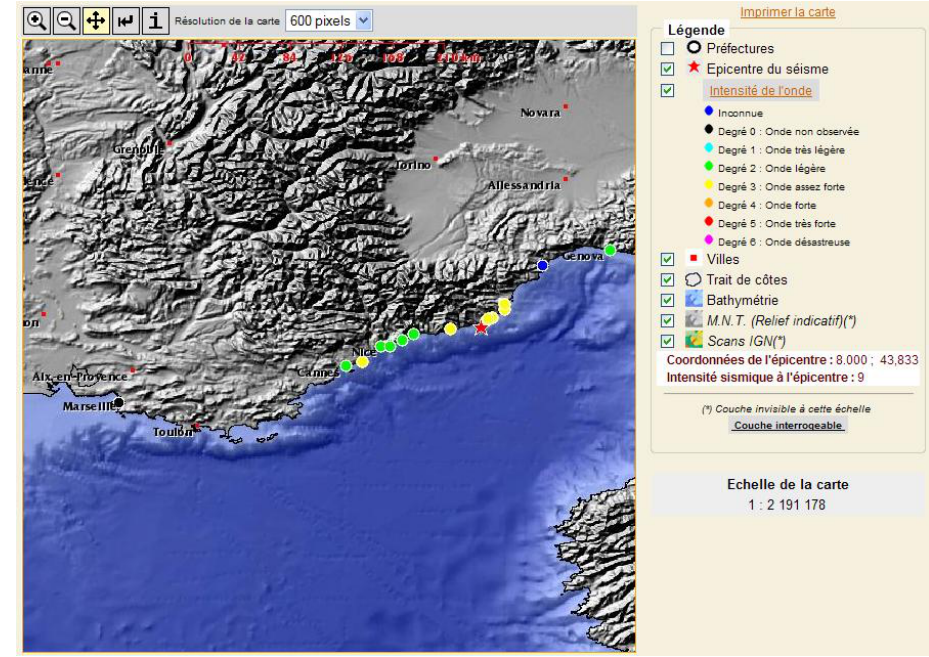
Fig. 3 – "Tsunami intensity map" window: intensities of the 23 February 1887 tsunami in the Mediterranean